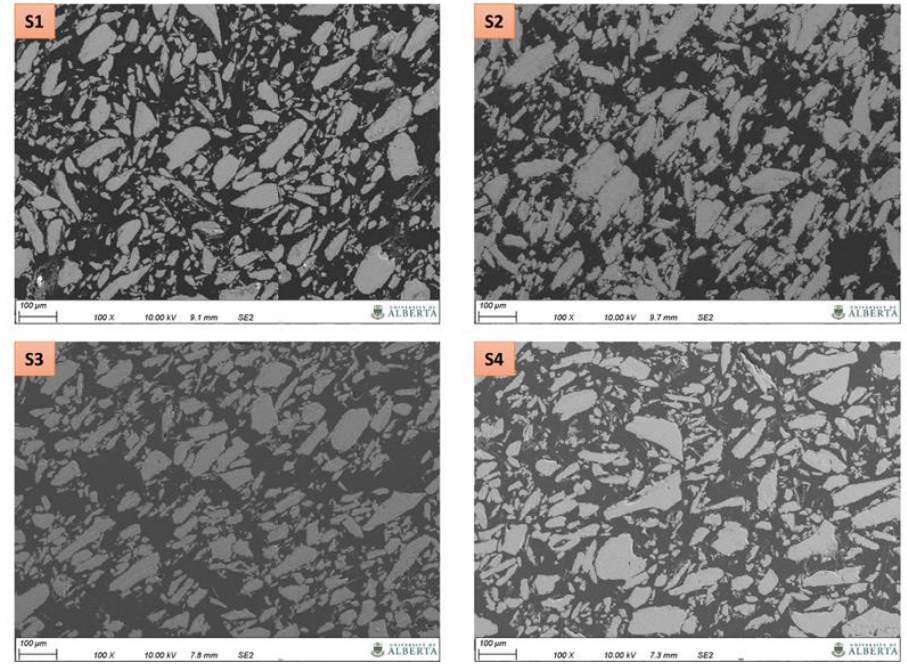
Figure 8. SEM images of magnetic composites as listed in Table 1.